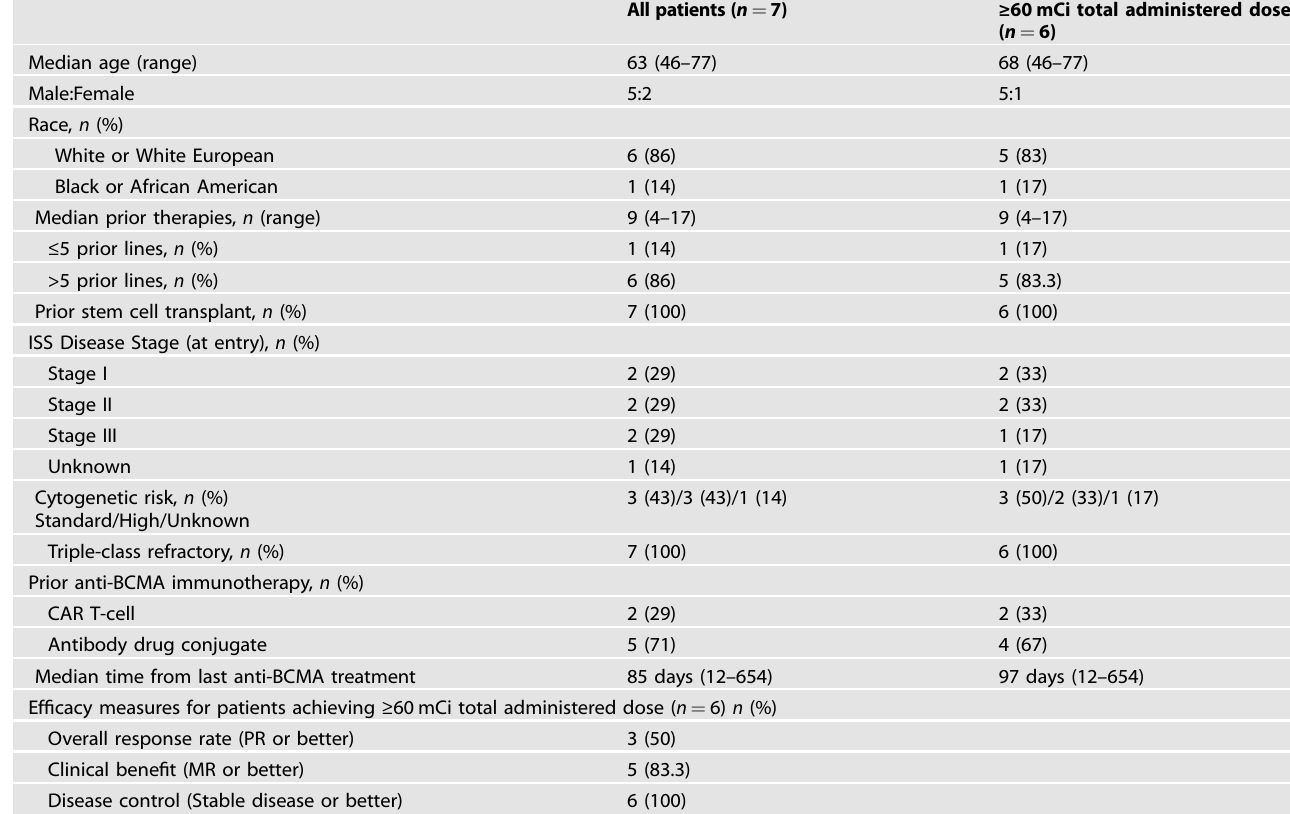
Table 1. Baseline characteristics and ef fi cacy measures of patients included in this analysis.